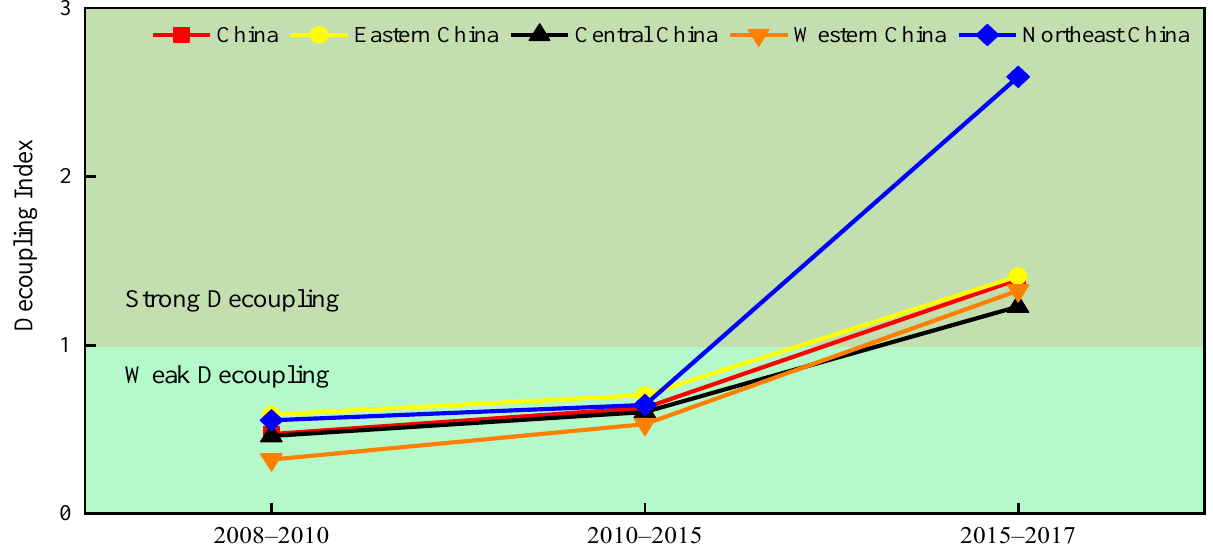
Figure 5. Decoupling trends of PM 2.5 emissions in the medium term.